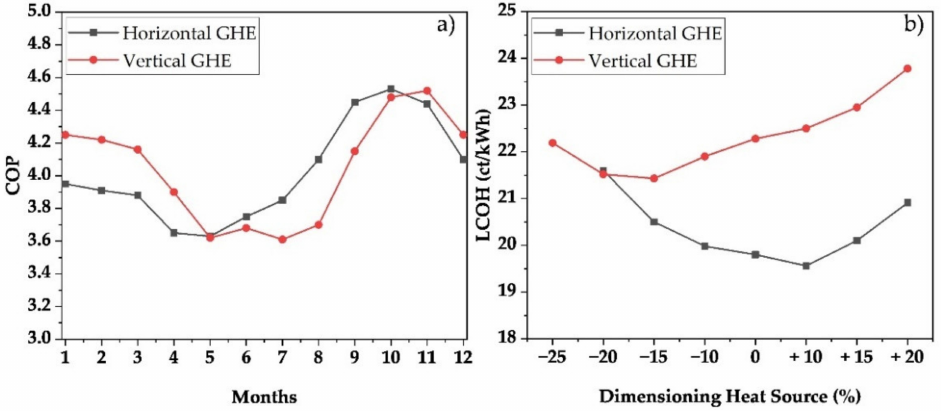
Figure 5. Overall COP for the design case ( a ) and LCOH for various dimensioning of the geothermal heat source ( b ).